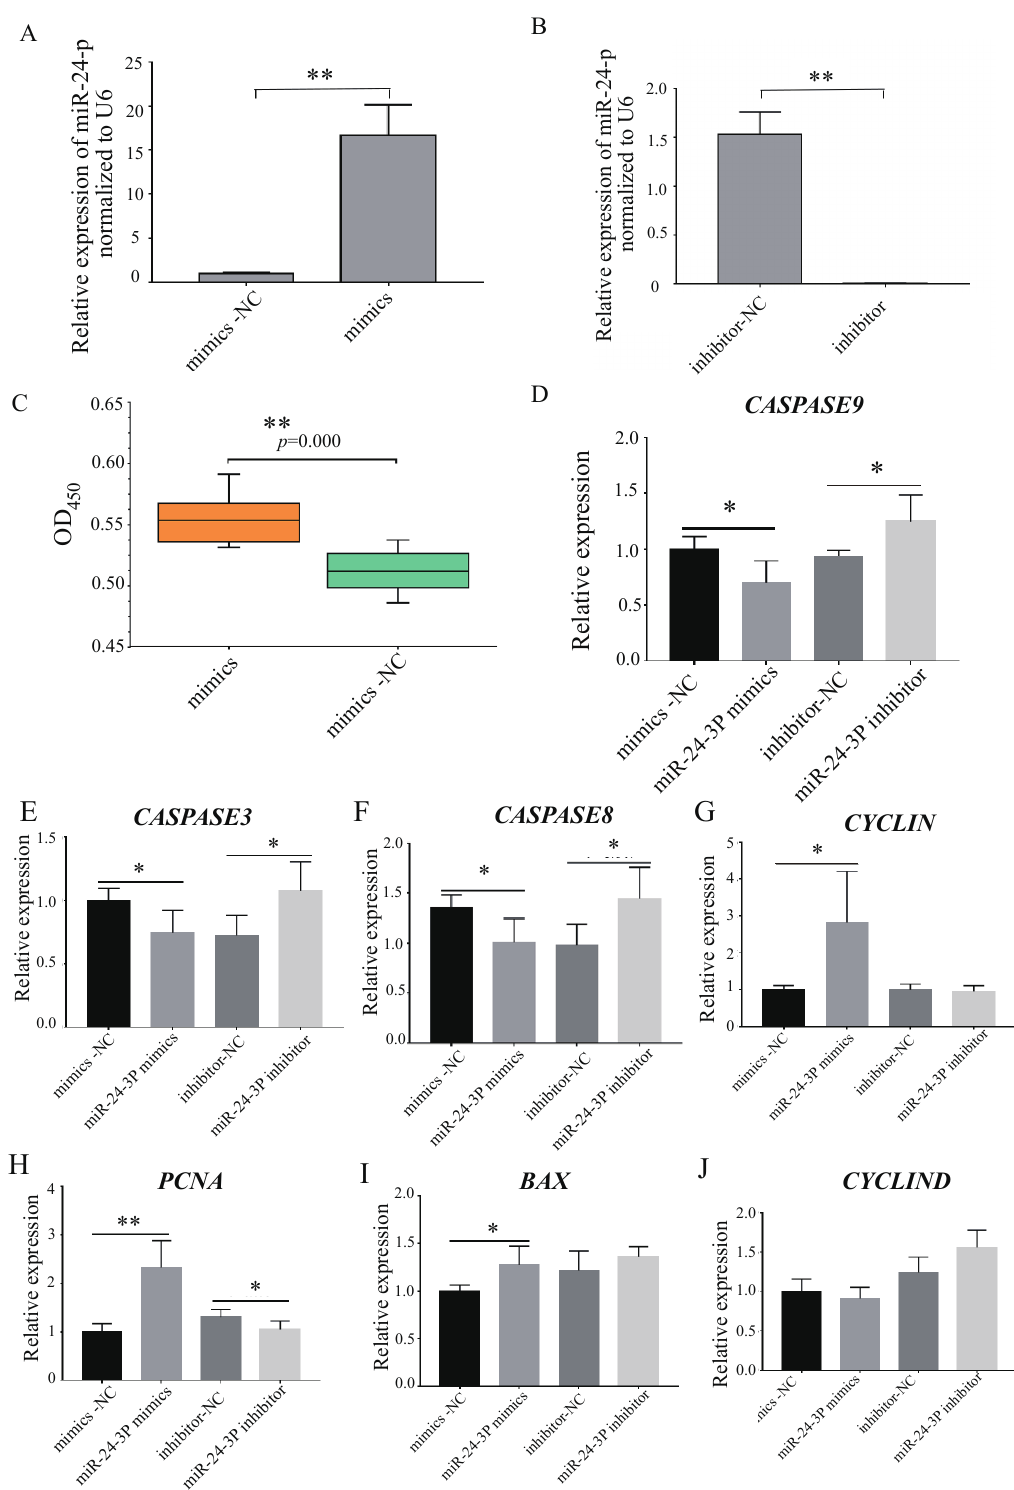
Figure 2. MiR-24-3p regulates C2C12 cell proliferation and apoptosis. ( A ) Overexpression efficiency detection of mmu-miR-24-3p by RT-qPCR. ( B ) Inhibition efficiency detection of miR-24-3p by RT- qPCR. ( C ) Cell proliferation status was detected at 450 nm with the CCK-8 reagent after an increase in miR-24-3p. ( D – J ) The expression of the CASPASE9 , CASPASE3 , CASPASE8 , CYCLINE , CYCLIND , PCNA , and BAX genes after overexpression and inhibition of miR-24-3p, respectively. * p < 0.05, ** p <